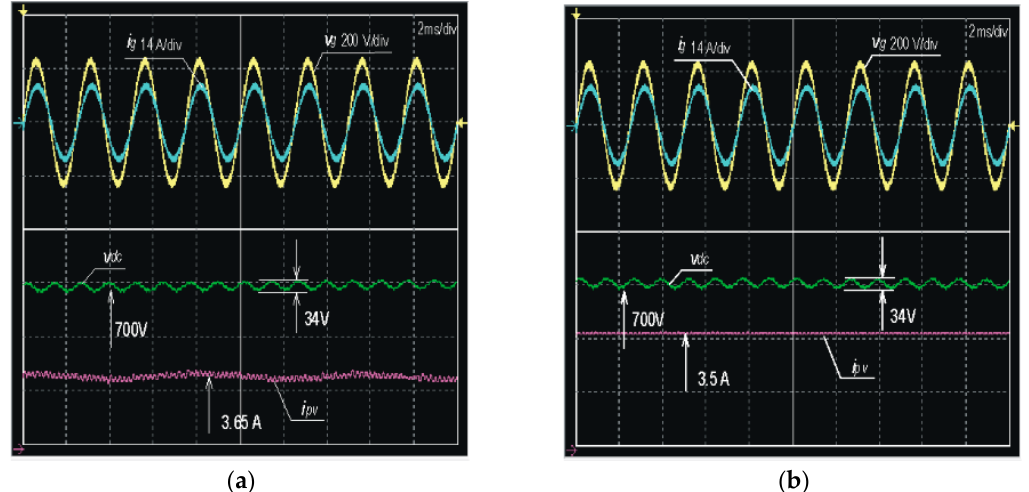
Figure 7. Experimental results showing the grid voltage v g in V and current i g in A, decoupling capacitor voltage v dc in V with the fixed DC offset, and the PvP output current i PV in A with the fixed DC offset for: ( a ) the incremental conductance method with a fixed step; ( b ) the proposed MPPT